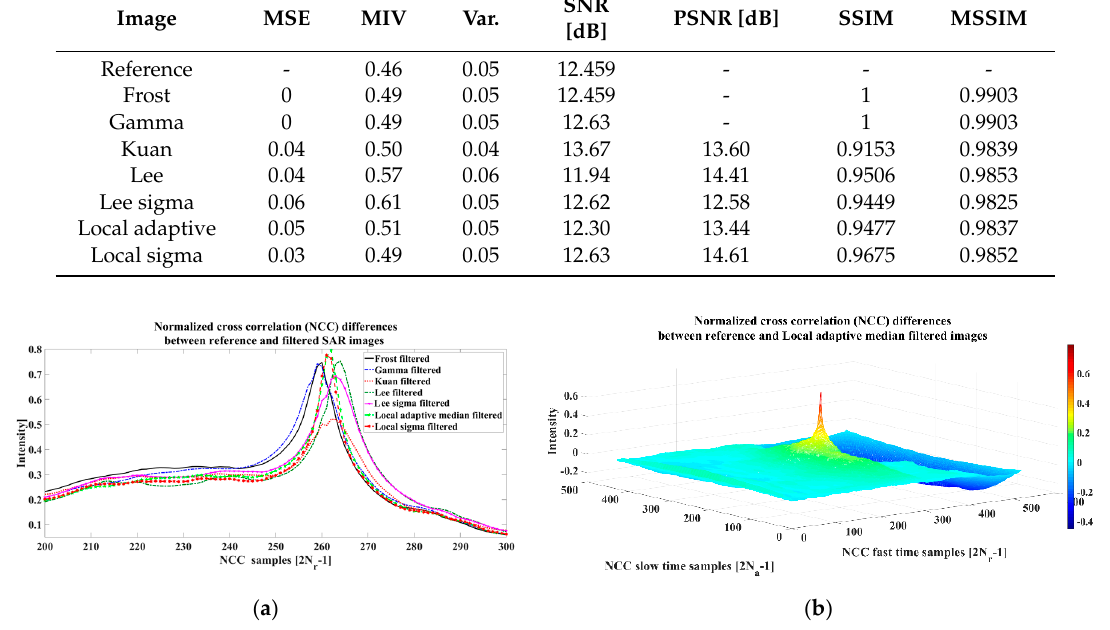
Figure 12. NCC ( a ) difference between the reference SAR image and de-speckled sample; ( b ) between the Local adaptive median filter and reference image.